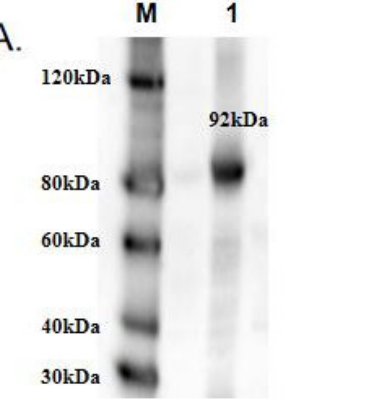
Figure 5. HPLC chromatograms presenting the deacetylation activity of TwCDA. ( A ) Chromato- gram of TwCDA with (GlcNAc) 5 as substrate. ( B ) Chromatogram of TwCDA with β-chitin as sub- strate. The retention time of acetic acid standard was 15.389 min (black curves). Acetic acid was produced in both experimental groups (dark blue and light blue curves) but not in the control groups (gray and green curves). 3.4. Chitinolytic Activity of TwCDA The DNS assay showed that reducing sugars were produced in the products of the four experimental groups (TwCDA and TwCDA-S against pentamer and β-chitin). Taking